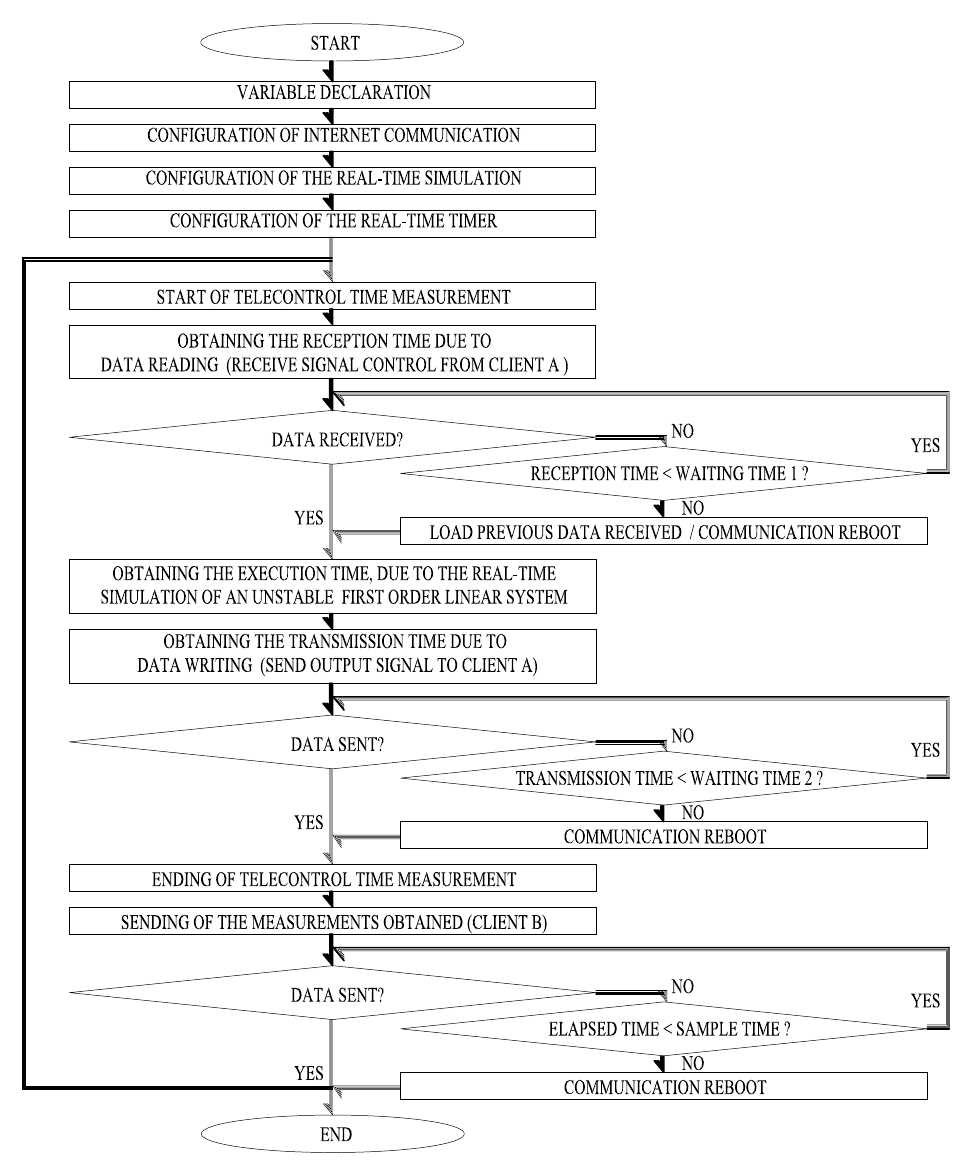
Figure 3. User interface flow diagram developed for the telecontrol